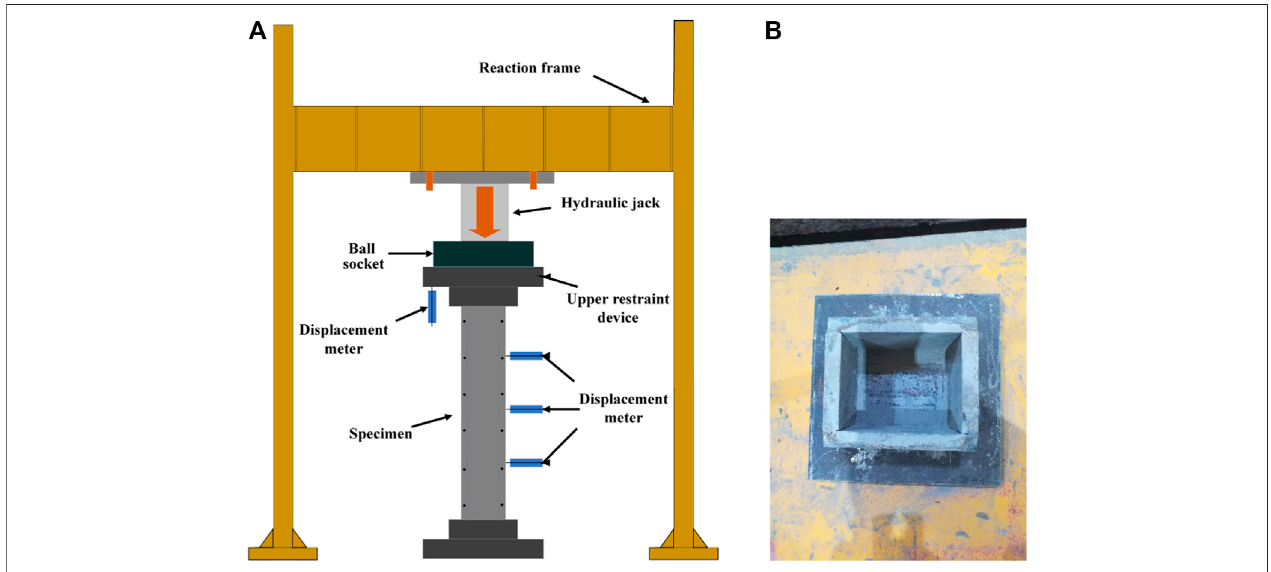
FIGURE 2 | (A) Schematic diagram of test loading. (B) Head restraint